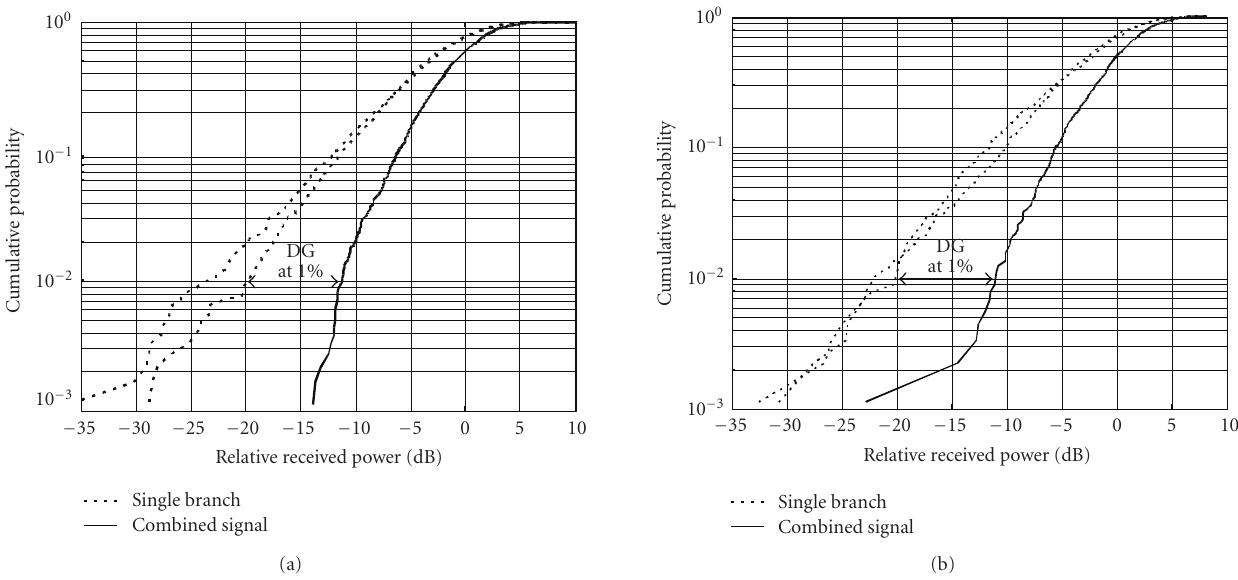
Figure 8: Measured cumulative probability of the two-antenna systems over a 20 MHz bandwidth at 2 GHz; (a) initial structure, (b) neu- tralized structure.